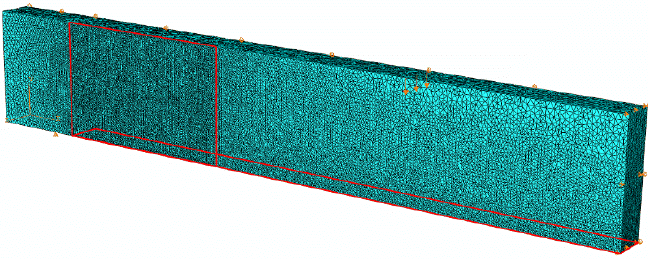
Figure 4. Three-dimensional (3D) Finite Element (FE) mesh.